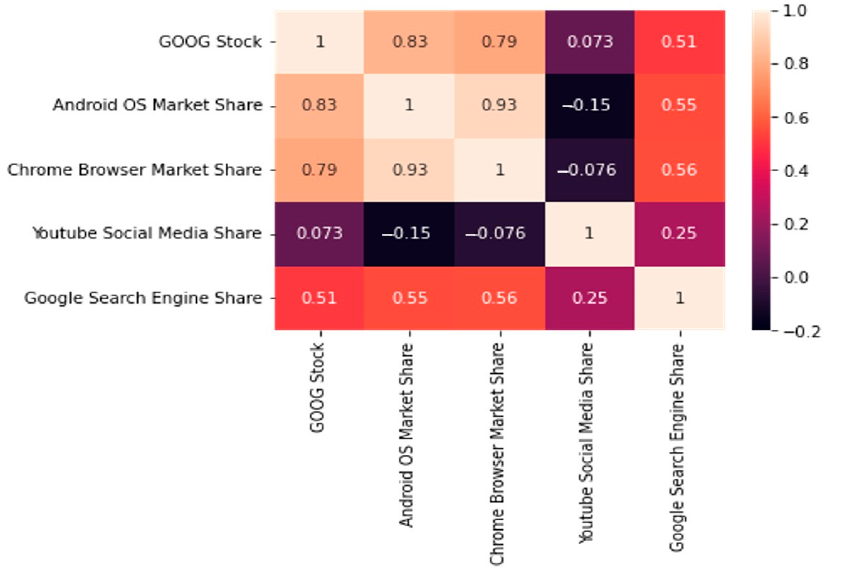
Figure 4. Heat map of correlation analysis of Google products [7,10,18,23].